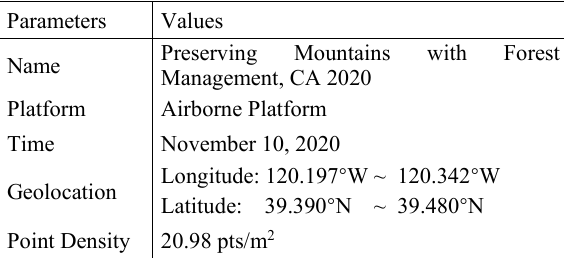
Table 2 . Reference dataset description.